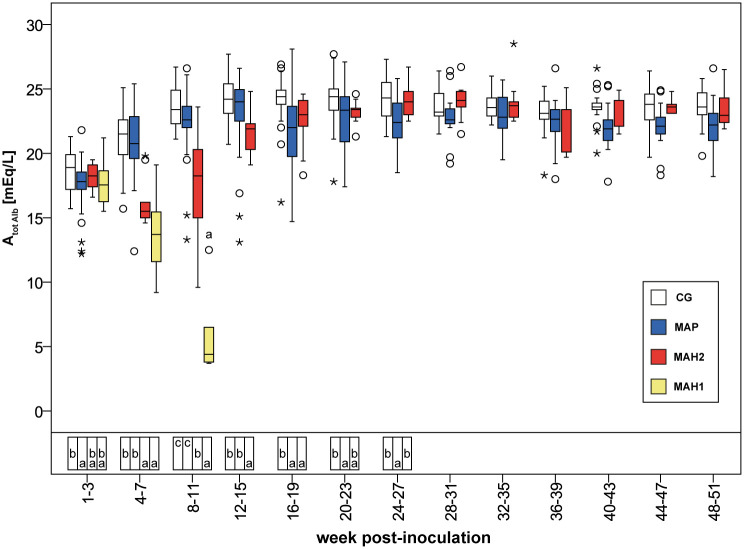
Calculated acid total based on albumin in mEq/L assessed in venous blood.CG, control group. MAP, group infected with Mycobacterium avium subsp. paratuberculosis. MAH 1, sub-group infected with Mycobacterium avium subsp. hominissuis with acute, severe form of infection. MAH 2, sub-group with chronic form of infection. Different letters indicate significant differences between groups within one period (Mann-Whitney U-test, P < 0.05). n.s., no significant differences between groups in the given period. From 28th week onwards Mann-Whitney U-test was not performed due to reduced numbers of observations. Significant differences within groups (Friedman test, P < 0.05) from 1st-3rd to 24th-27th wpi are given in S3–S5, and S10 Tables.